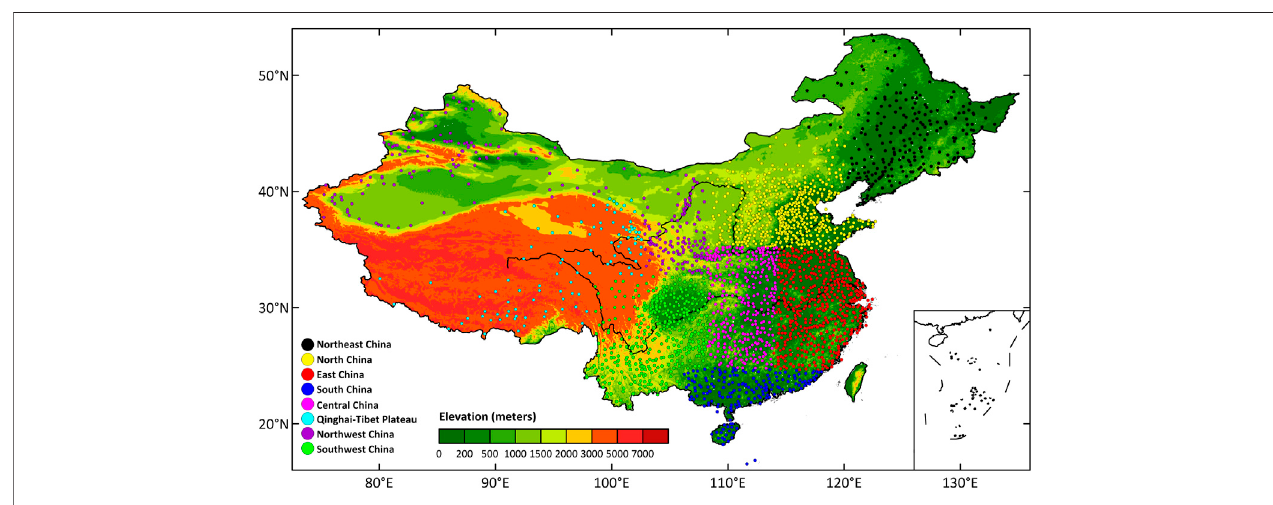
FIGURE 1 | Distribution of meteorological stations and elevation in different regions of China.